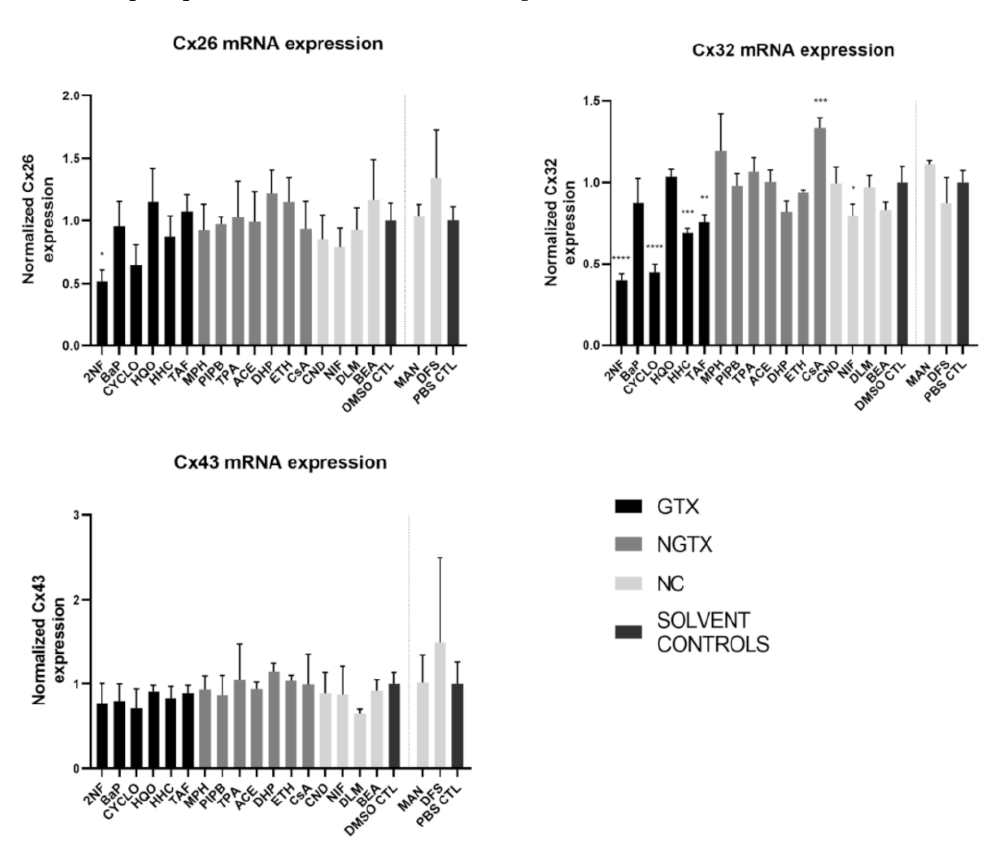
Figure 2. Connexin (Cx) gene expression in human hepatoma HepaRG cells exposed to GTX, NGTX, and NC chemicals. Human hepatoma HepaRG cells ( n = 3 and N = 2) were exposed to GTX, NGTX, and NC chemicals for 72 h and compared to their respective solvent control (DMSO CTL or PBS CTL). Total RNA was extracted, and expression levels were measured by means of real-time reverse transcription quantitative polymerase chain reaction (RT-qPCR) analysis. Data were analyzed with the 2 − ∆∆ Ct formula in qbase+ (Biogazelle, Belgium). Significance was calculated with a parametric one-way ANOVA followed by a Dunnett’s post-hoc test to correct for multiple comparisons. Data are expressed as mean ± standard deviation with * p ≤ 0.05 ** p ≤ 0.01 *** p ≤ 0.001 and **** p ≤ 0.0001. The GTX chemical 2-nitrofluorene (2NF) was the only chemical that significantly re- duced Cx26 mRNA levels. Four GTX chemicals, namely 2NF, cyclophosphamide (CYCLO), hydrazine dihydrochloride (HHC), and 2-acetylaminofluorene (TAF) and the NC chemical nifedipine (NIF), lowered Cx32 expression, while cyclosporine A (CsA), an NGTX chemical, positively affected Cx32. No changes were induced by any of the chemicals on Cx43 mRNA expression